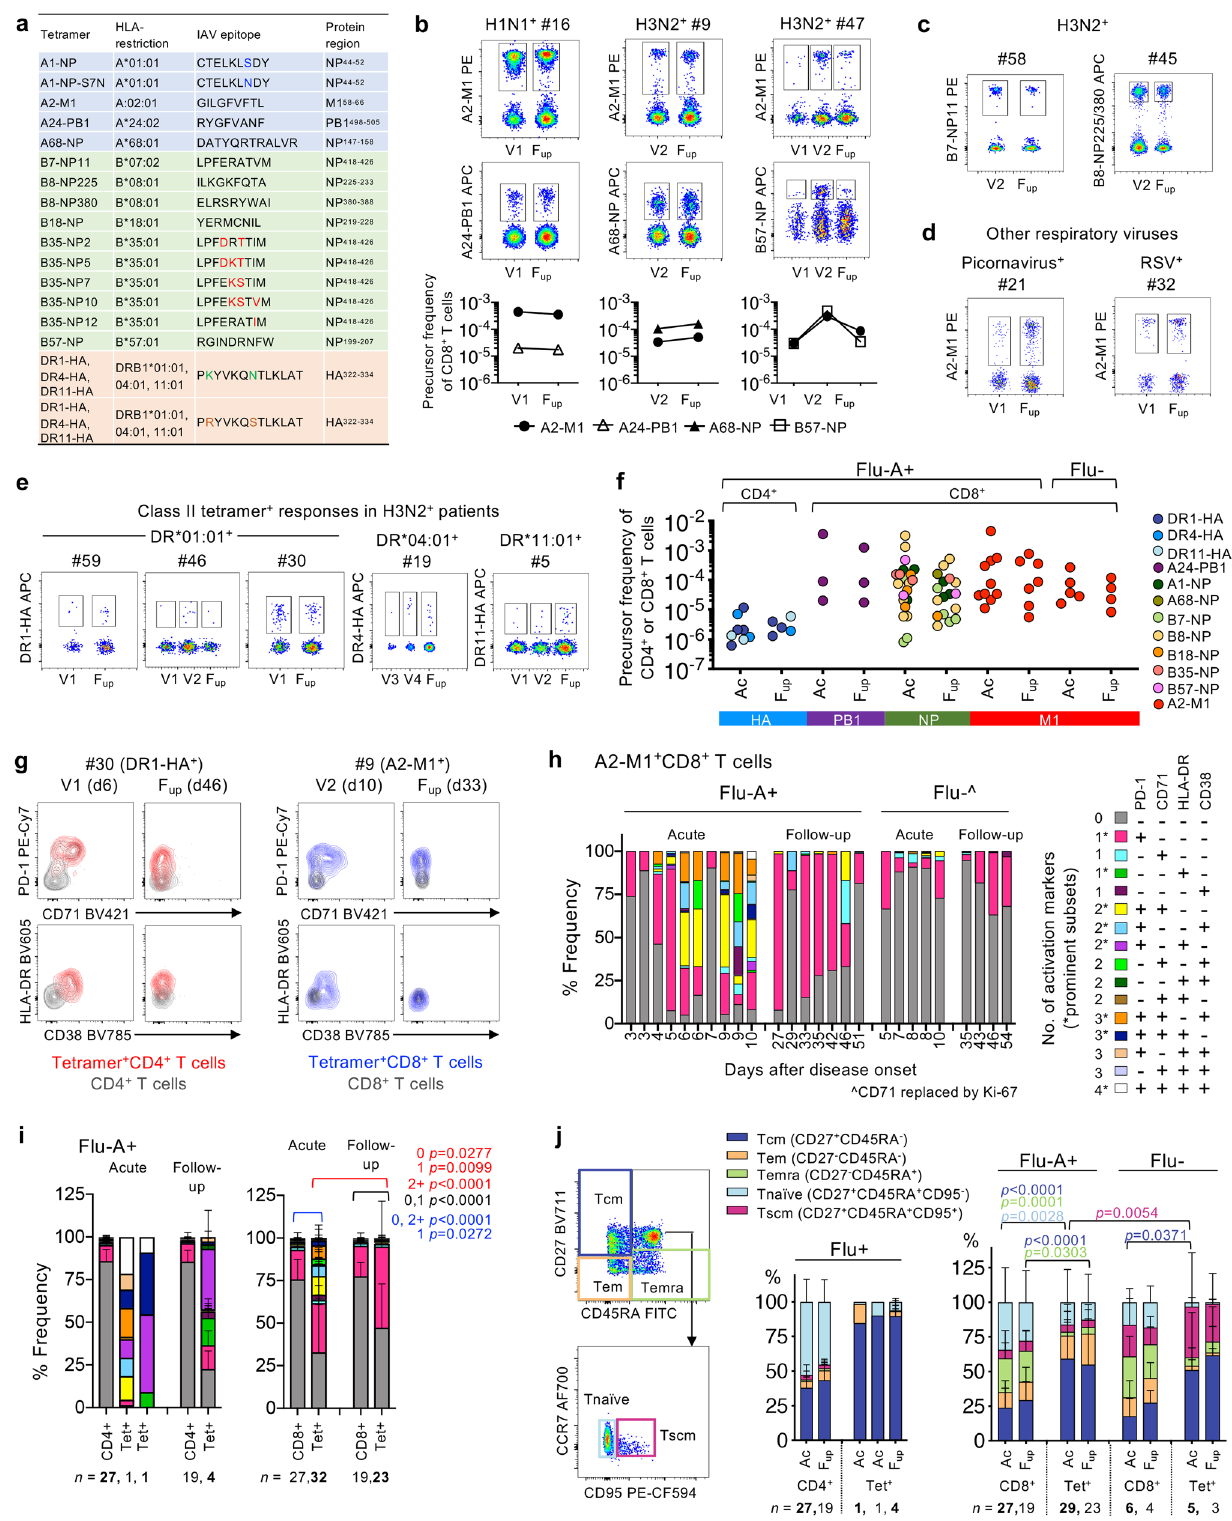
27:05/57:01 molecules binding universally conserved in fl uenza peptides 40 versus HLA-A * 24:02/68:01 types positively correlating with pH1N1 mortality 15 and morbidity 16 . Similarly, for IFITM3 SNP analyses, the non-risk rs12252-T/T homozygous allele was observed in 91% of in fl uenza + patients (remaining were C/T het- erozygous) and 100% of in fl uenza- patients, whereas the risk C/C homozygous allele was absent. The rs34481144 SNP showed